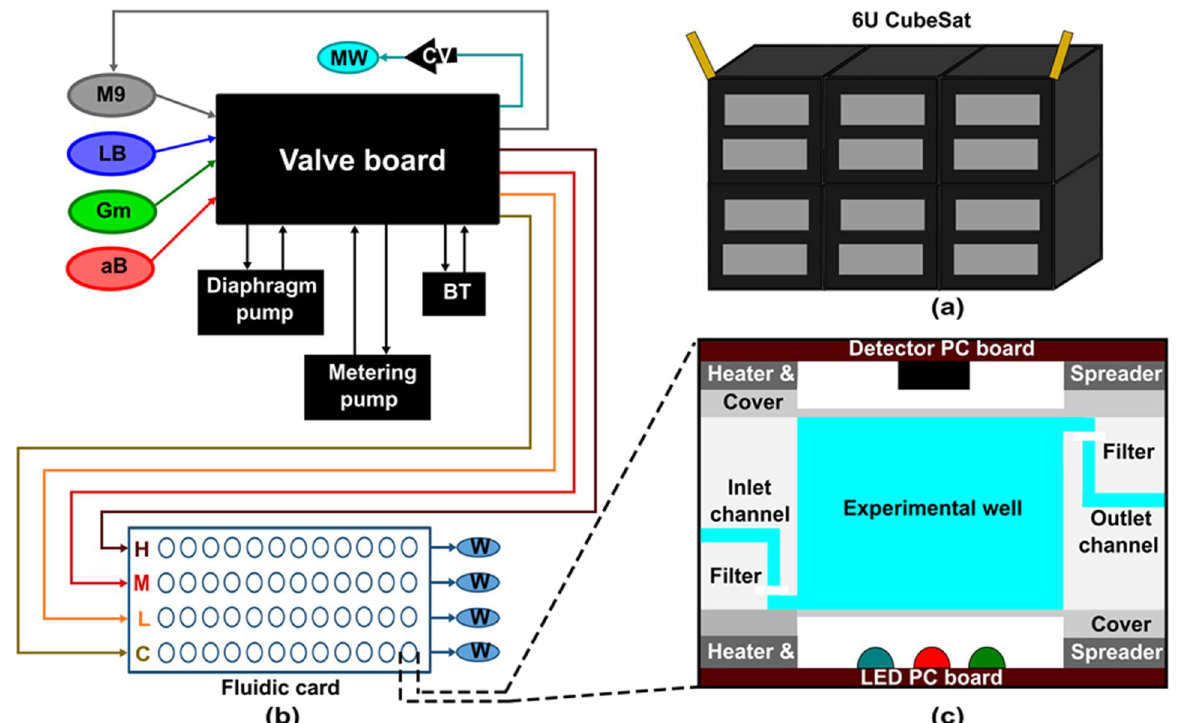
Figure 8. EcAMSat CubeSat design and fluidic system. ( a ) Schematic design presentation of 6U CubeSat. ( b ) The simplified fluidic system of EcAMSat. BT = bubble trap; CV = check valve; MW = main waste bag; W = card waste bag; C, L, M, H = control, low, medium, and high banks of the card, referring to the relative does of Gm delivered to each bank. ( c ) Cross-section of the experimental well in the fluidic system of EcAMSat. (Adapted with permission from [106]. Copyright 2020, Elsevier Ltd.)